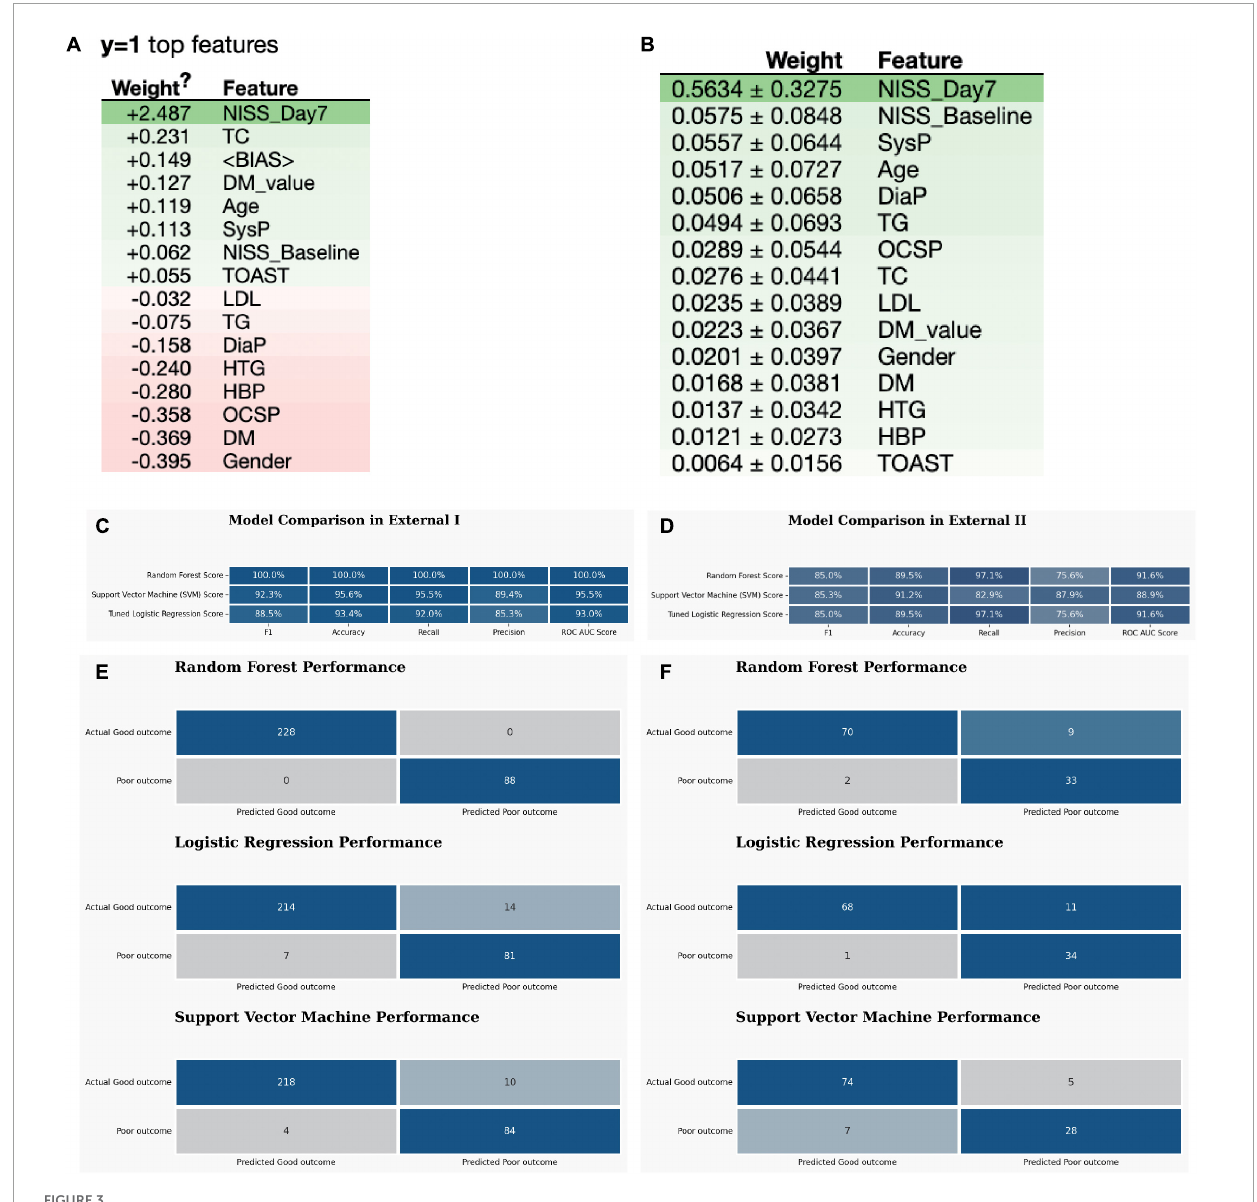
FIGURE3 The external validation of the optimized three ML models. (A,B) The eli5 model shows the weight of each feature in the RF model. (C) The model quality comparison in the external dataset I. (D) The model quality comparison in the external dataset II. (E) The confusion matrix for three models in the external dataset I. (F) The confusion matrix for three models in the external dataset